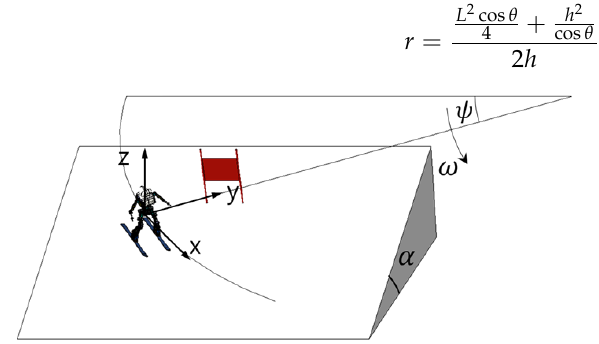
Figure 8. Top view of ski slope.